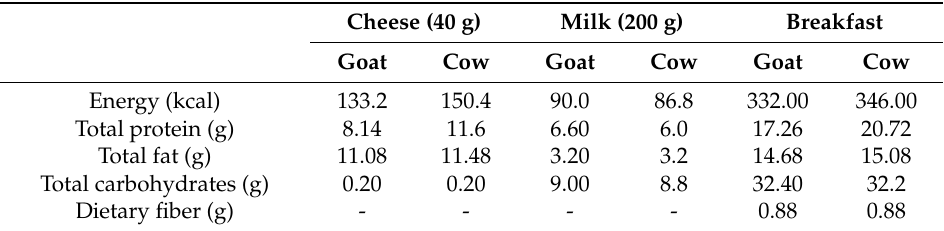
Table 1. Total macronutrient composition and energy content. Cheese (40 g) Milk (200 g) Breakfast Goat Cow Goat Cow Goat